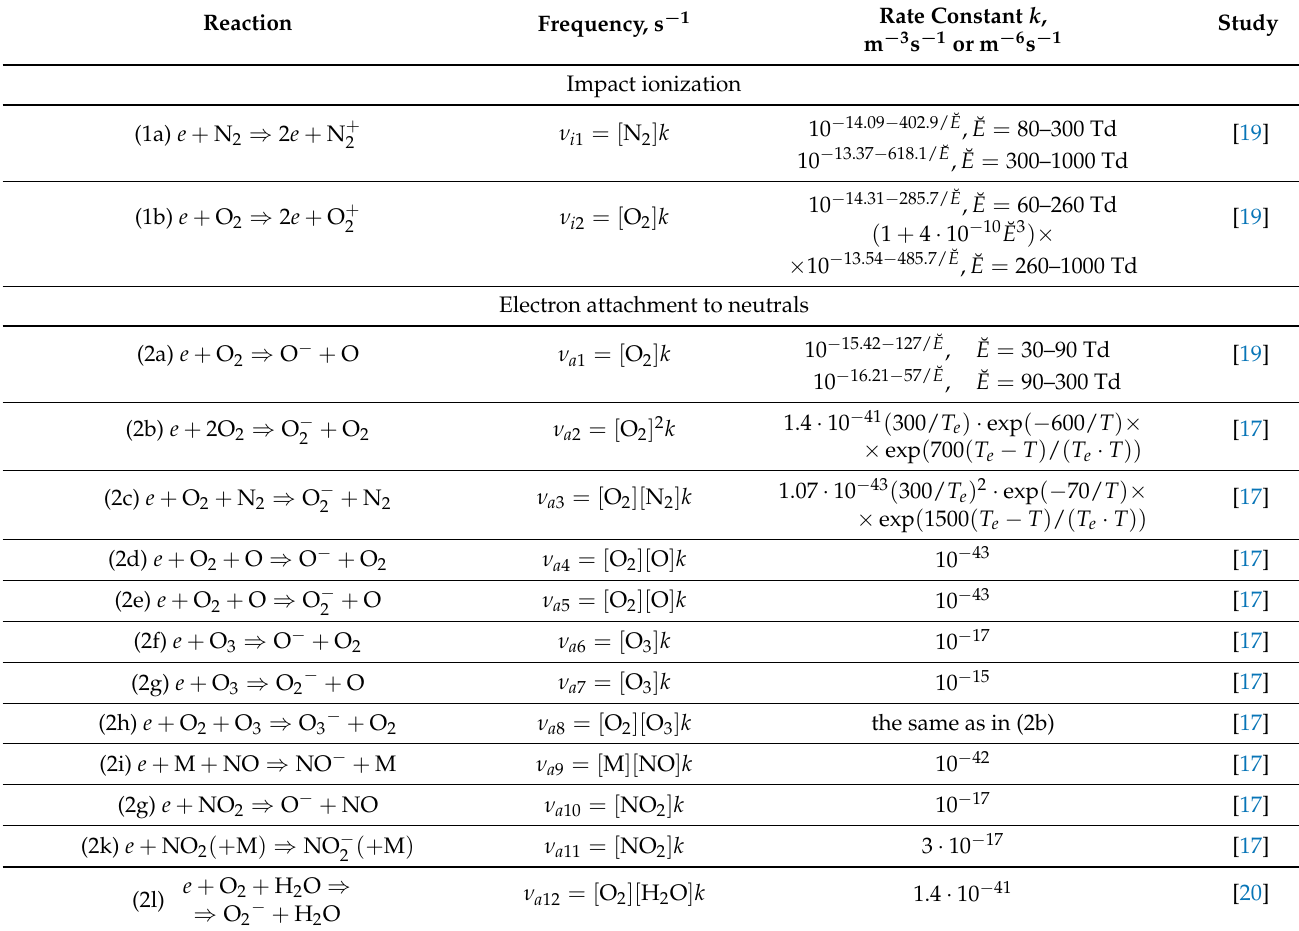
Table A1. The list of model